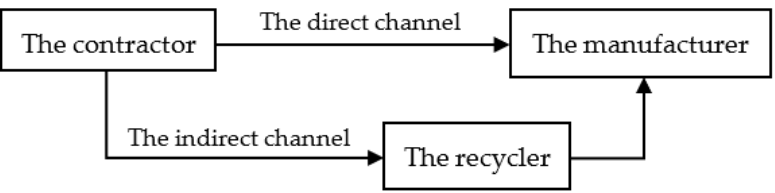
Figure 1. The graphical structure of the dual-channel supply chain.